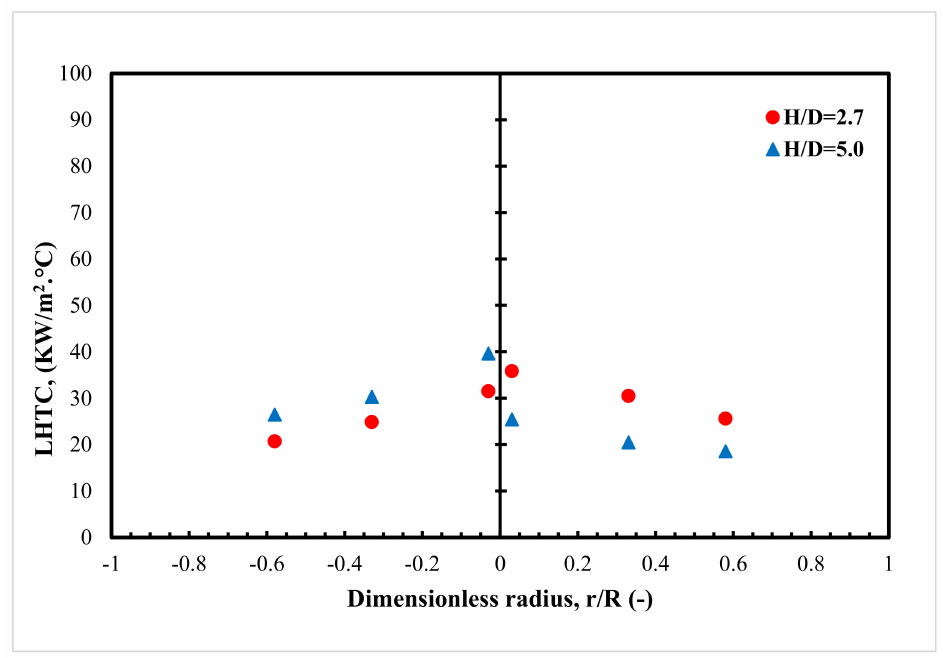
Figure 12. LHTC profiles measured at the different axial levels of 35 and 70 cm and an operating gas velocity of 0.05 m/s.